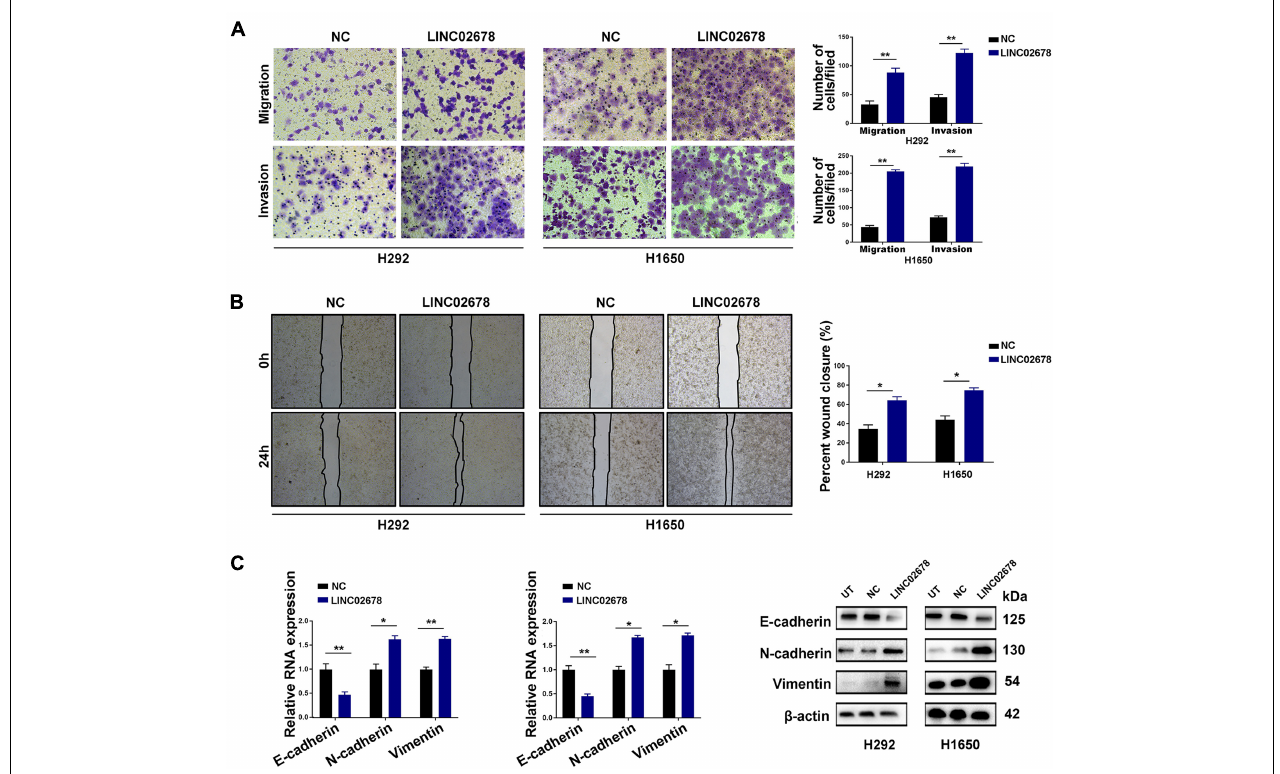
FIGURE 4 | Up-regulated LINC02678 expression promotes migration, invasion and EMT of NSCLC cells. (A,B) The effects of up-regulated LINC02678 expression on the migration and invasion of H292 and H1650 cells were evaluated by wound healing experiment and Transwell assay. (C) Evaluation of EMT-related markers was performed by RT-qPCR and western blotting. (* p < 0.05; ** p < 0.01. Data were obtained from three independent experiments).